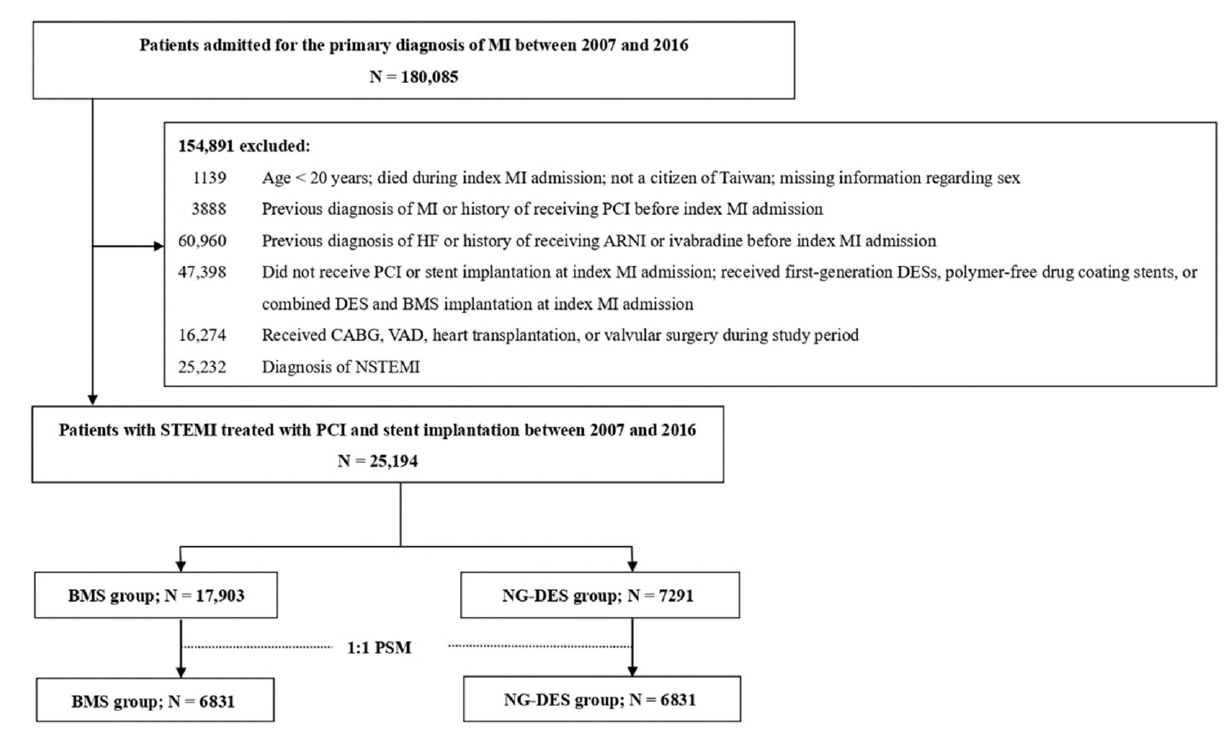
Figure 1. Patient selection process. ARNI—angiotensin receptor/neprilysin inhibitor; BMS—bare- metal stent; CABG—coronary artery bypass grafting; DES—drug-eluting stent; HF—heart failure; MI = myocardial infarction; N—number; NG-DES—new-generation drug-eluting stent; NSTEMI— non-ST-elevation myocardial infarction; PCI—percutaneous coronary intervention; PSM—propensity score matching; STEMI—ST-elevation myocardial infarction; VAD—ventricular assist device.